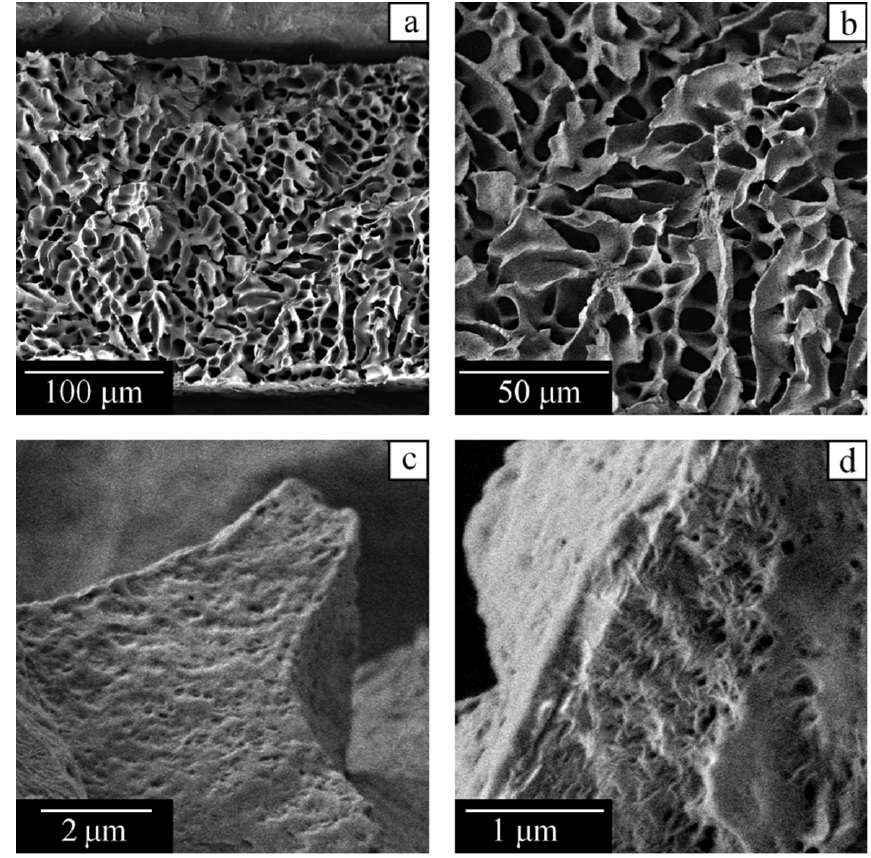
Figure 12. SEM images of the capillary-porous body obtained from the PVDF–camphor mixture containing 28 wt% of the polymer. Note the different scale bars in the images ( a − d ).